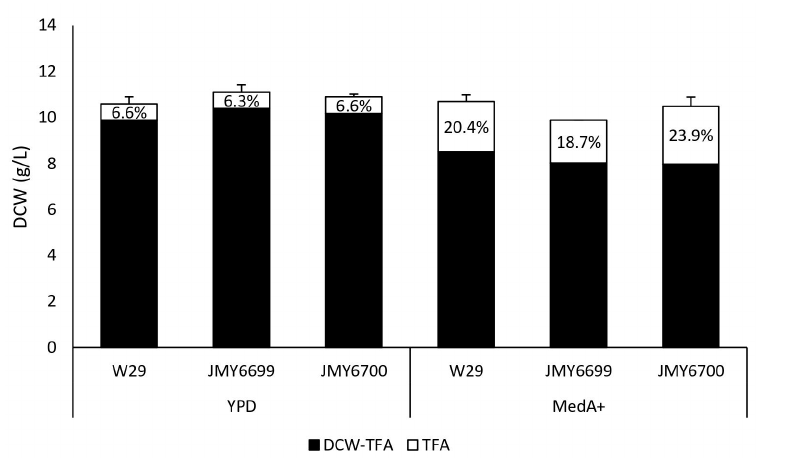
Figure 1. Biomass and lipid accumulation in W29 (control), JMY6699 ( pTEF-MsexD2 ), JMY6700 ( pTEF-MsexD3 ) cultured in two different media (YPD, 48 h; MedA+, 72 h) with glucose as the carbon source. Textured areas represent Lipid free biomass (g/L) and grey areas represent total fatty acids (g/L). Lipid accumulation (%) is expressed as a TFA to DCW ratio. Each value is an average of the values obtained from three independent experiments.